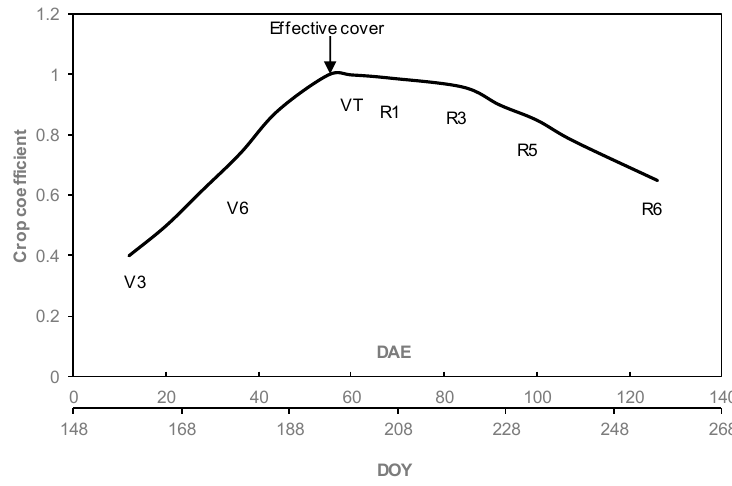
Figure 13. Crop coefficient curve of corn field throughout the 2016 growing season. DAE is days after emergence, DOY is day of year, and “V” and “R” refer to crop development stages.